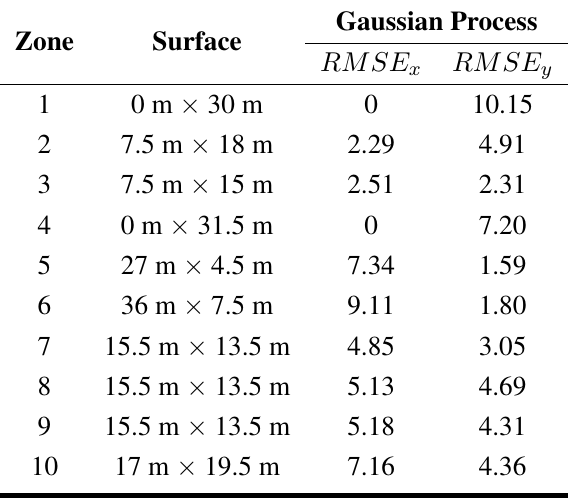
Table 7. RMSE (m) using only intensities based on manually-clustered data in Building